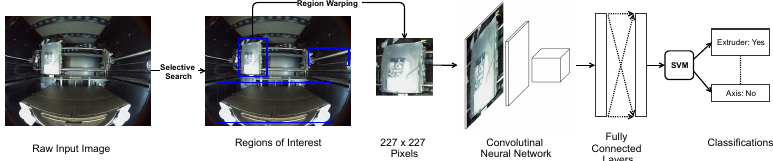
Figure 3. High-level architecture of the Region-based Convolutional Neural